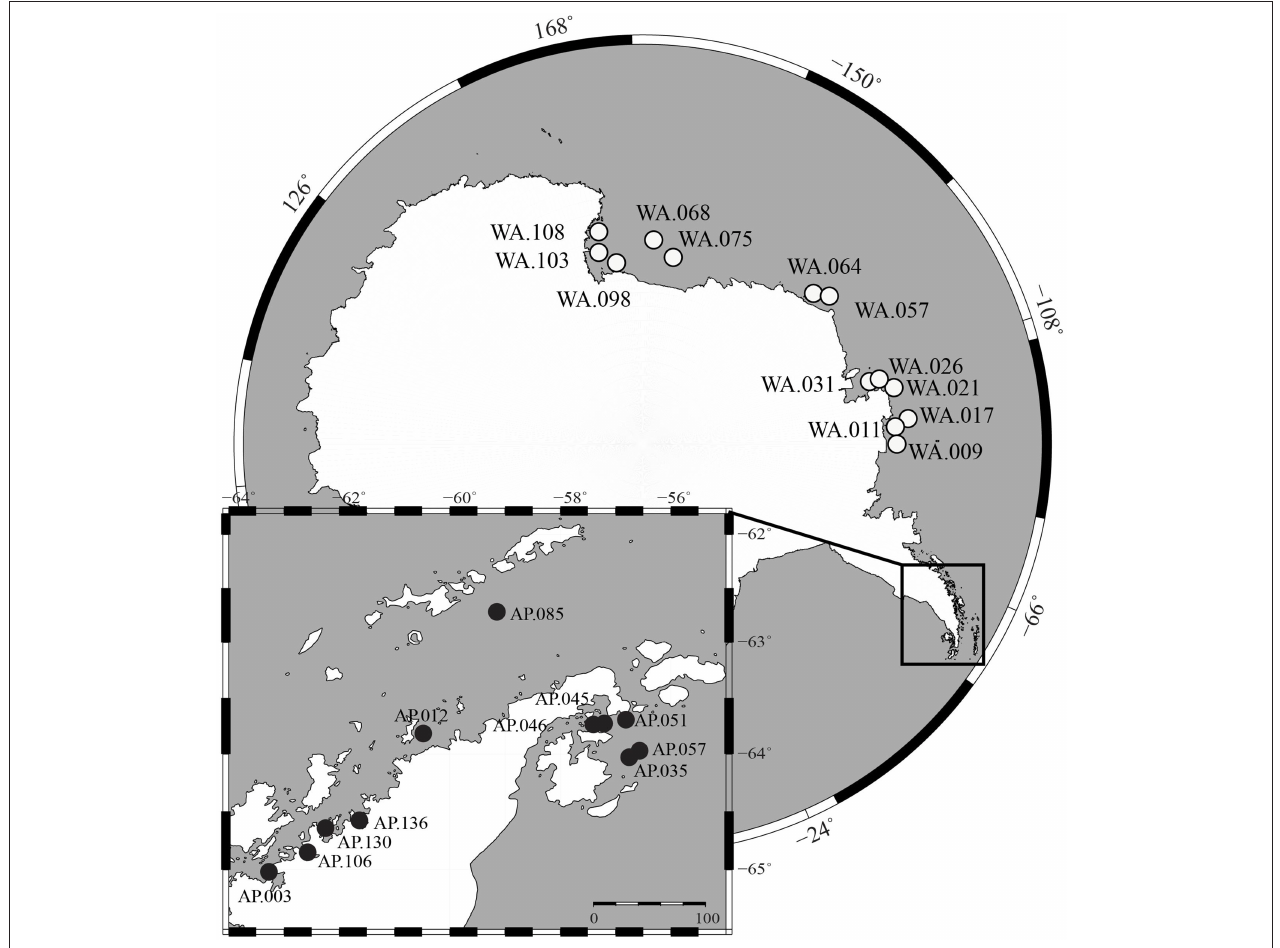
FIGURE 1 | Map of sample locations from Western Antarctica (WA, white circles) and Antarctic Peninsula (AP, black